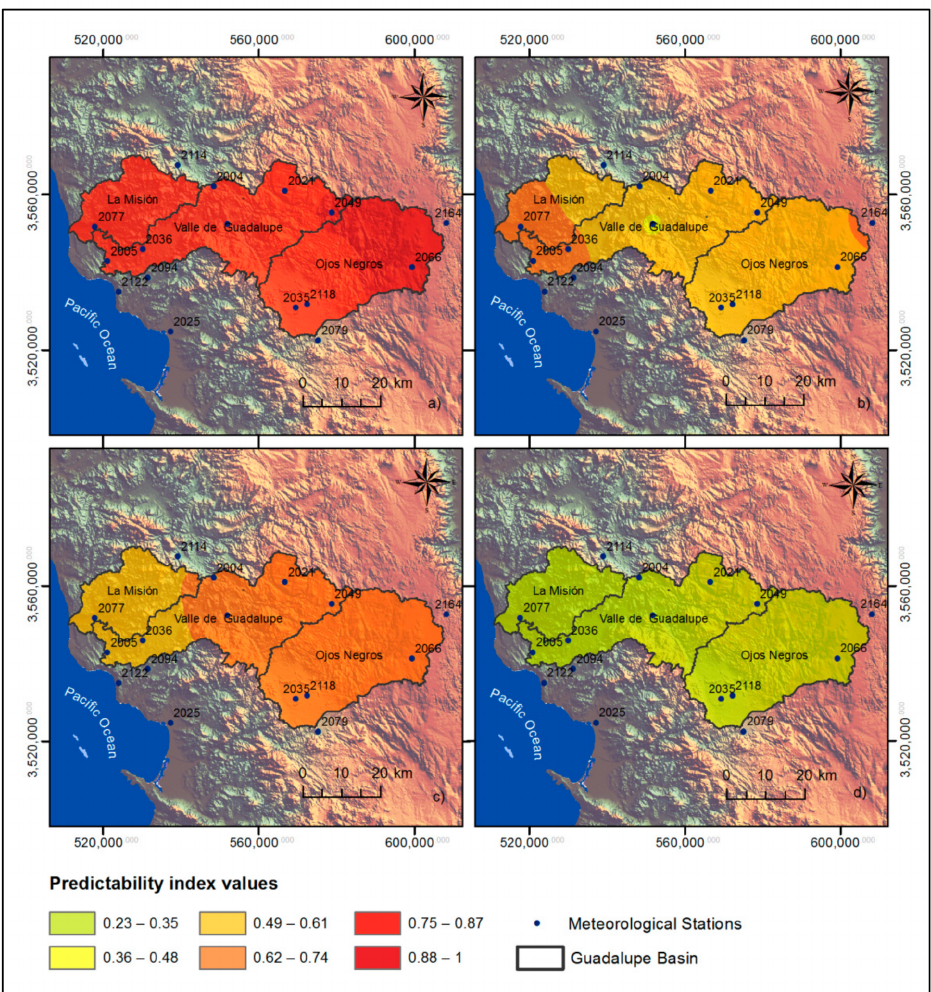
Figure 10. Maps of the predictability index for days without Santa Ana winds for the variables of ( a ) temperature, ( b ) pressure, ( c ) relative humidity, and ( d ) wind